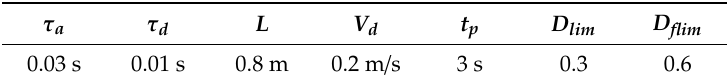
Table 1. Experimental parameters.